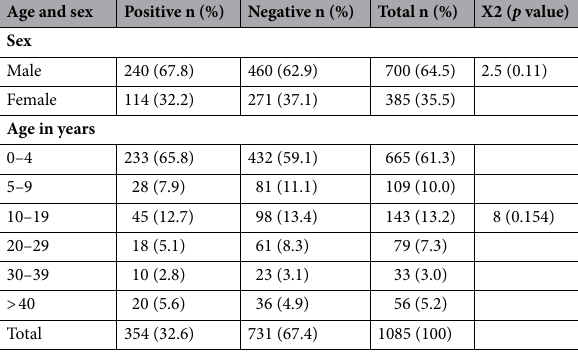
Table 1. Age and sex distribution of patients with rate of